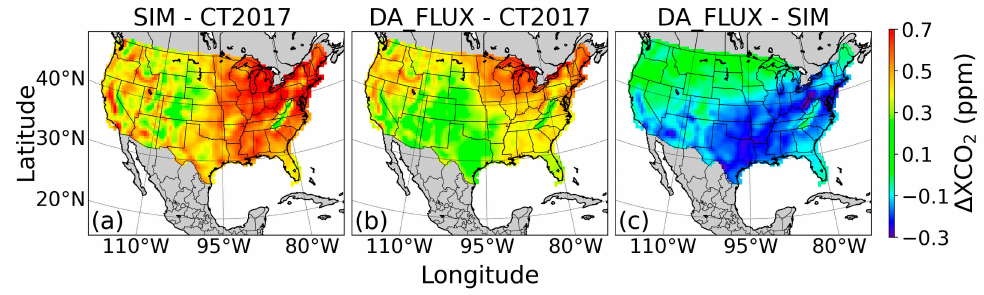
Figure 10. Difference in the annual mean XCO 2 distribution over the contiguous United States in 2016, ( a ) between SIM and CT2017, ( b ) between DA_FLUX and CT2017, ( c ) between DA_FLUX and SIM.